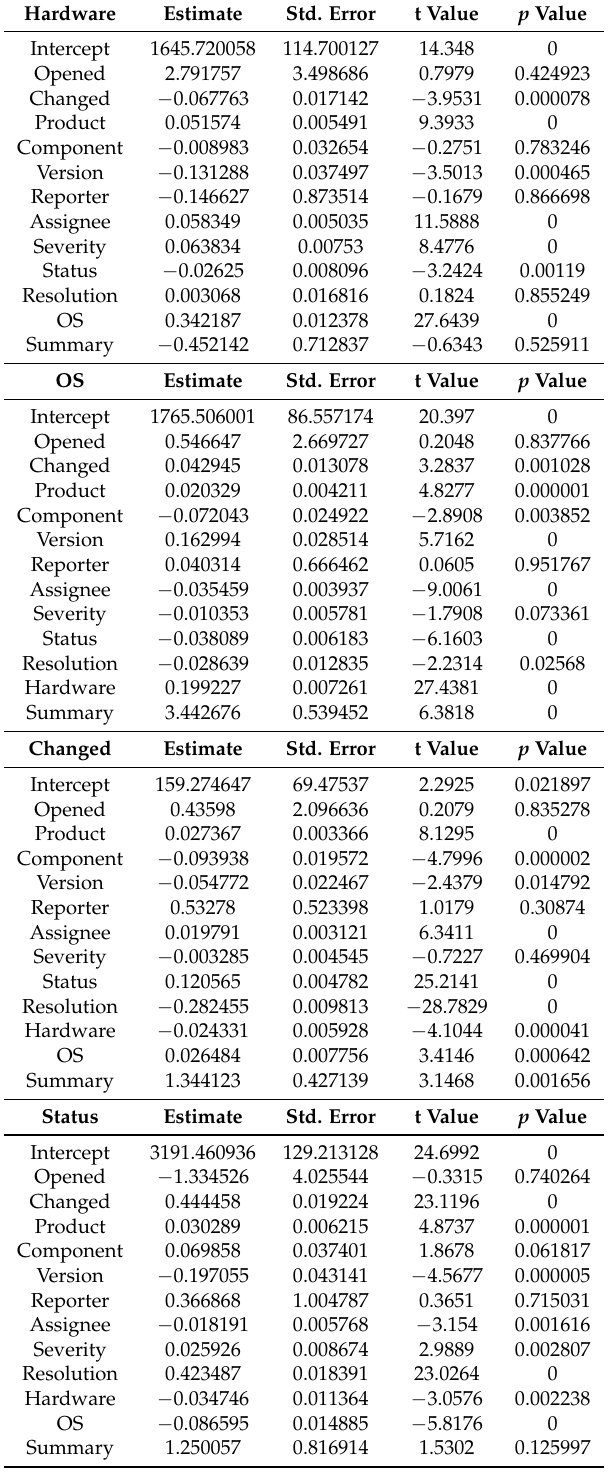
Table 3. The estimation results in cases Hardware, OS, Changed, and Status as objective